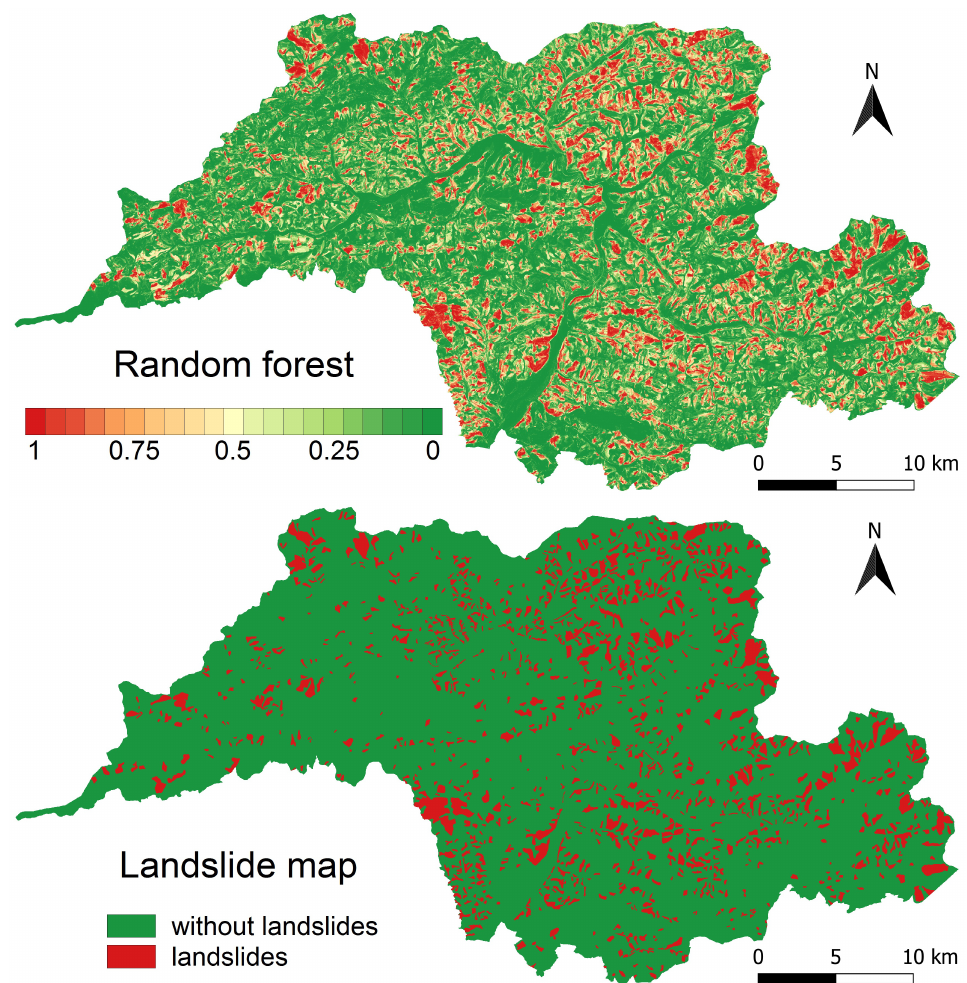
Figure 10. Visualisation of the landslide susceptibility maps based on the probabilities predicted by logistic regression and random forests models and the map of landslide inventory